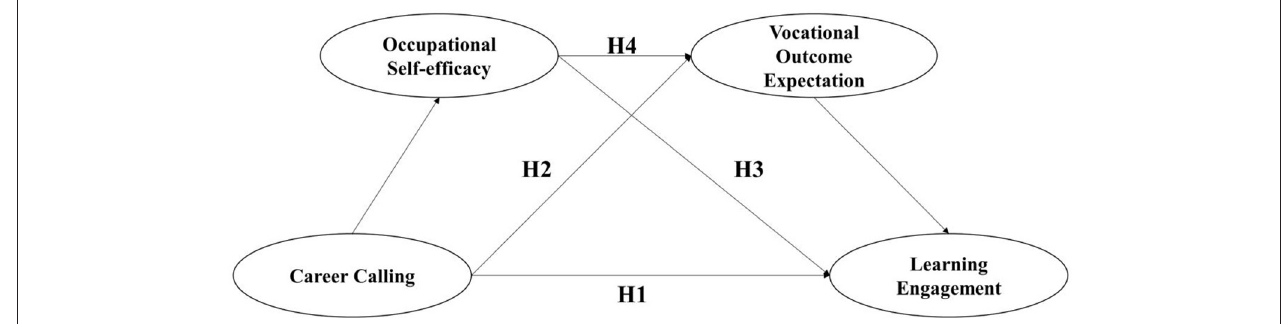
FIGURE 1 | Hypothesized model of mediated relationships between career calling and learning